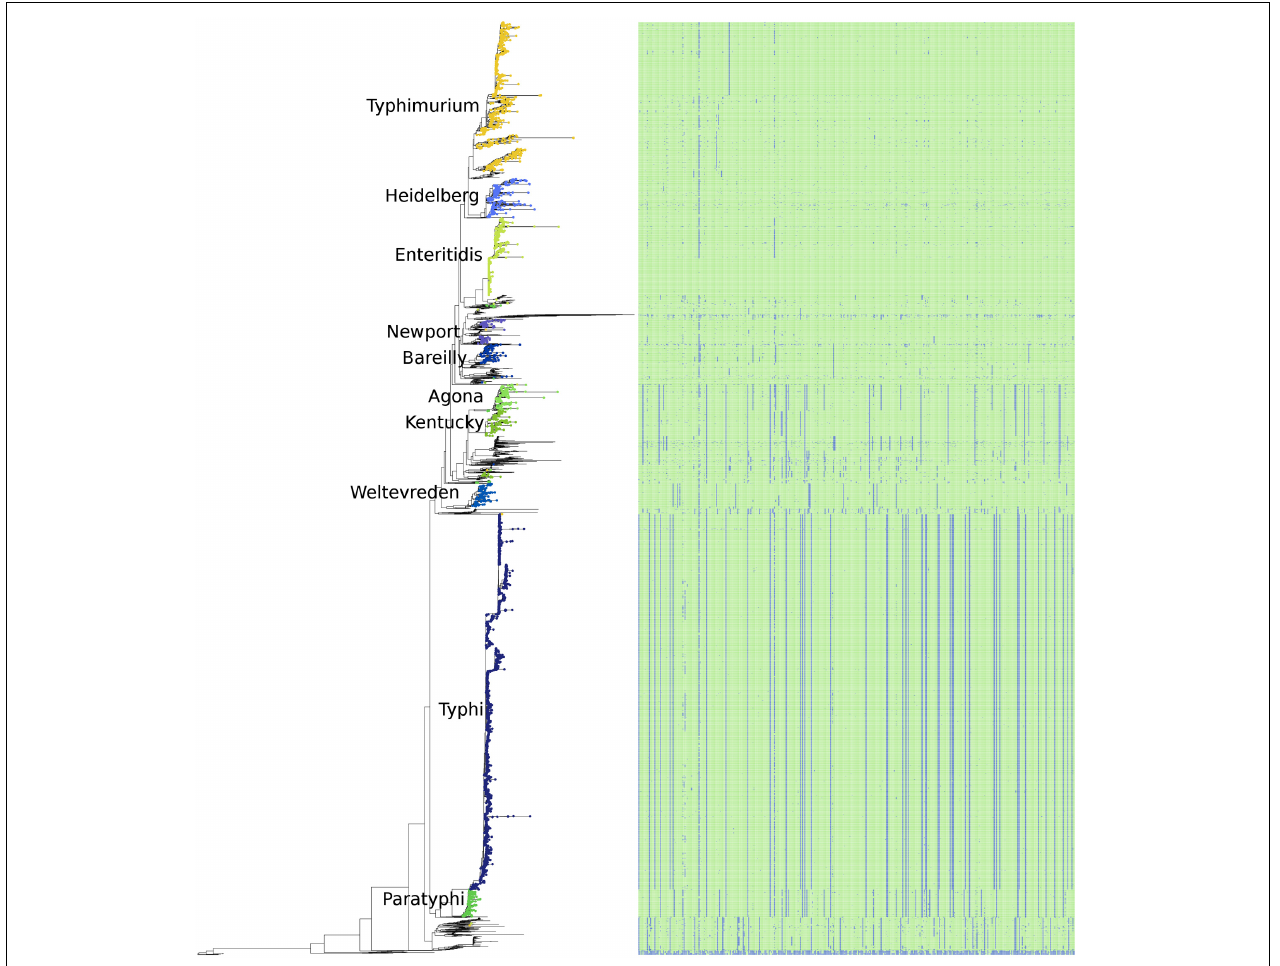
FIGURE 6 | The phylogeny of the 4893 S. enterica genomes post quality-filtering based on the presence/absence of the entire pan-genome as 1000 bp fragments. The 10 most abundant serovars of subspecies enterica in the current study (Agona, Bareilly, Enteritidis, Heidelberg, Kentucky, Newport, Paratyphi, Typhi, Typhimurium, Weltevreden) are labeled on the tree. The matrix to the right of the phylogeny represents the 404 species-specific regions, with blue being the absence of a region, and green being the presence of a region, for each of the genomes of the